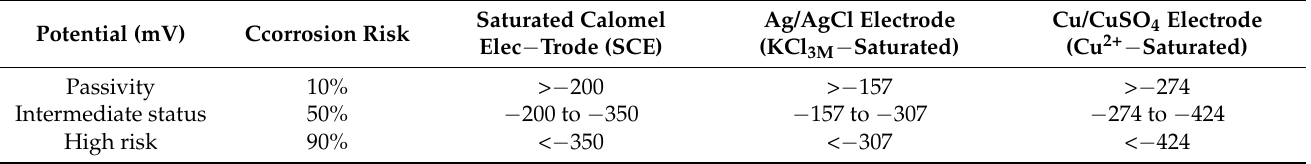
Table 4. Corrosion risk assessed in terms of corrosion